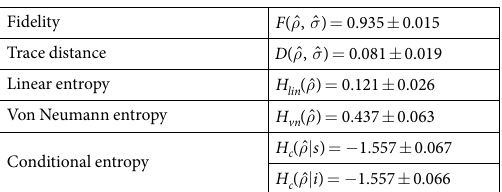
Table 1. Figures of merit for the reconstructed density operators. The errors were estimated as standard deviations in the four experimental trials, which means that the errors included not only statistical characteristics of the photon counts but also experimental